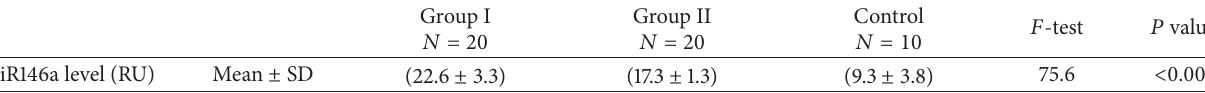
Table 2: Comparison between patient groups and control group as regards level of miRNA146a.